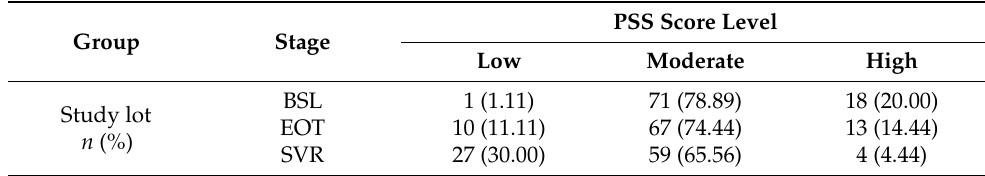
Table 2. The levels of perceived stress (PSS) within the study sample.